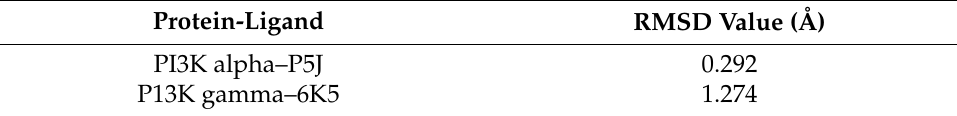
Table 1. RMSD value of co-crystallized (from PI3K Alpha) vs. docked